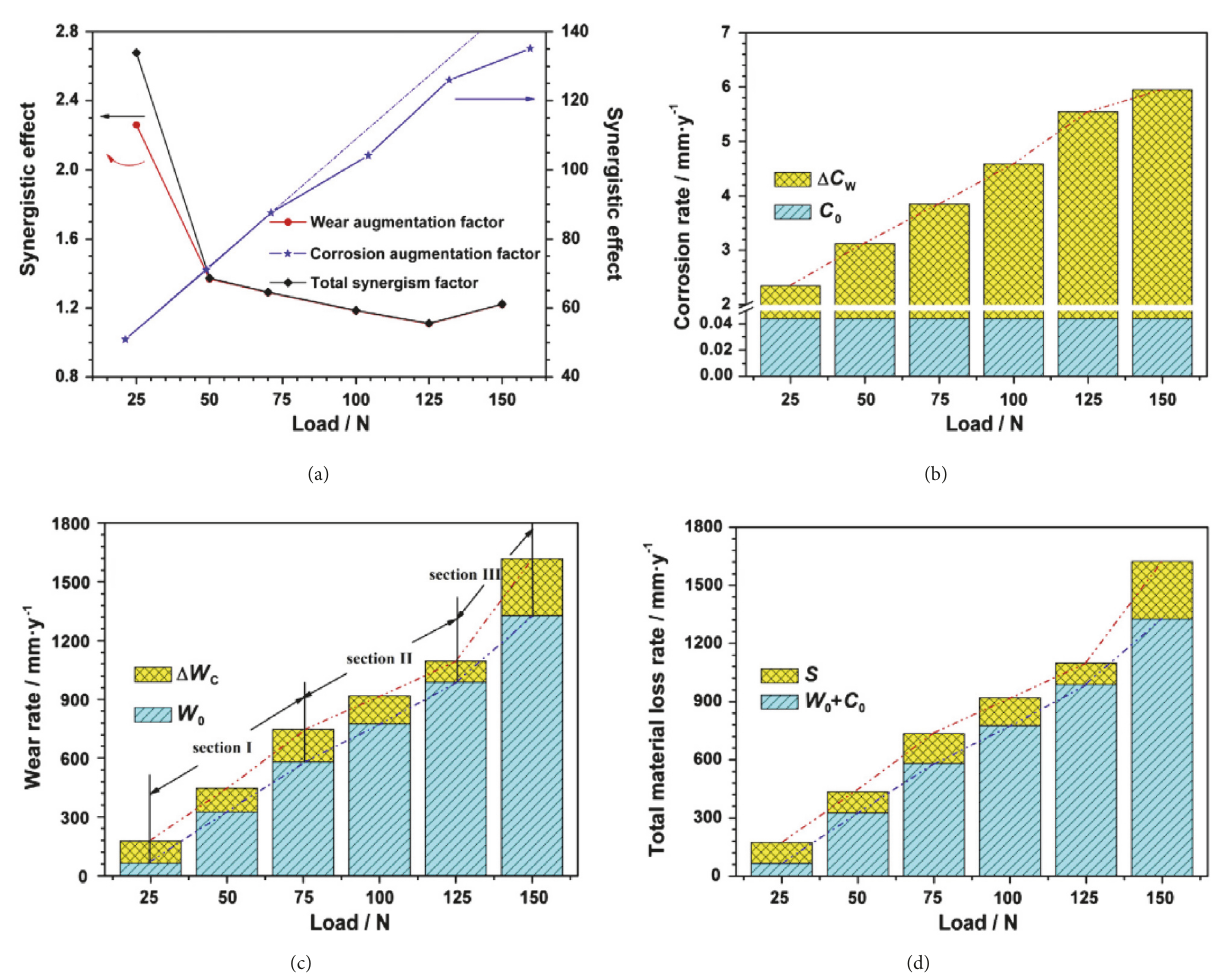
Figure 14: Synergetic contributions of mechanical wear and corrosion to each other and total material loss for a AISI 304 stainless steel at various applied loads in artificial seawater